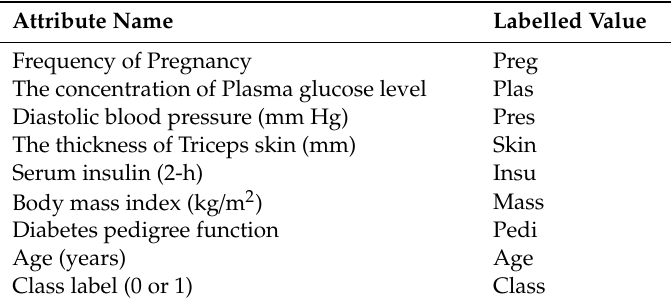
Table 2. Attribute Details of Pima Indian Diabetes [46].